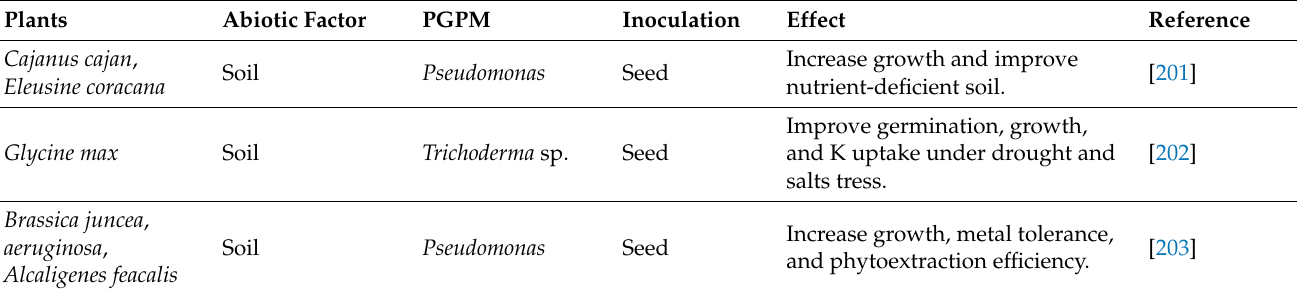
Table 4. Effect of microbes on plant ecophysiological parameters under abiotic